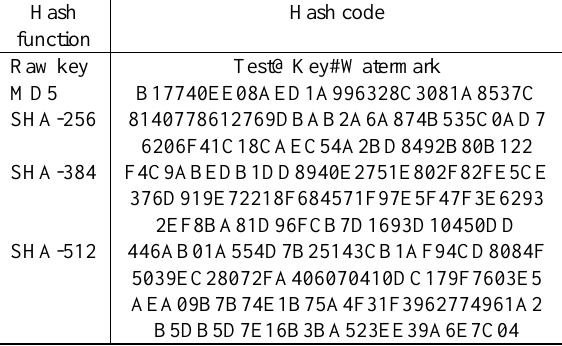
Table 2. Examples of different hash codes for